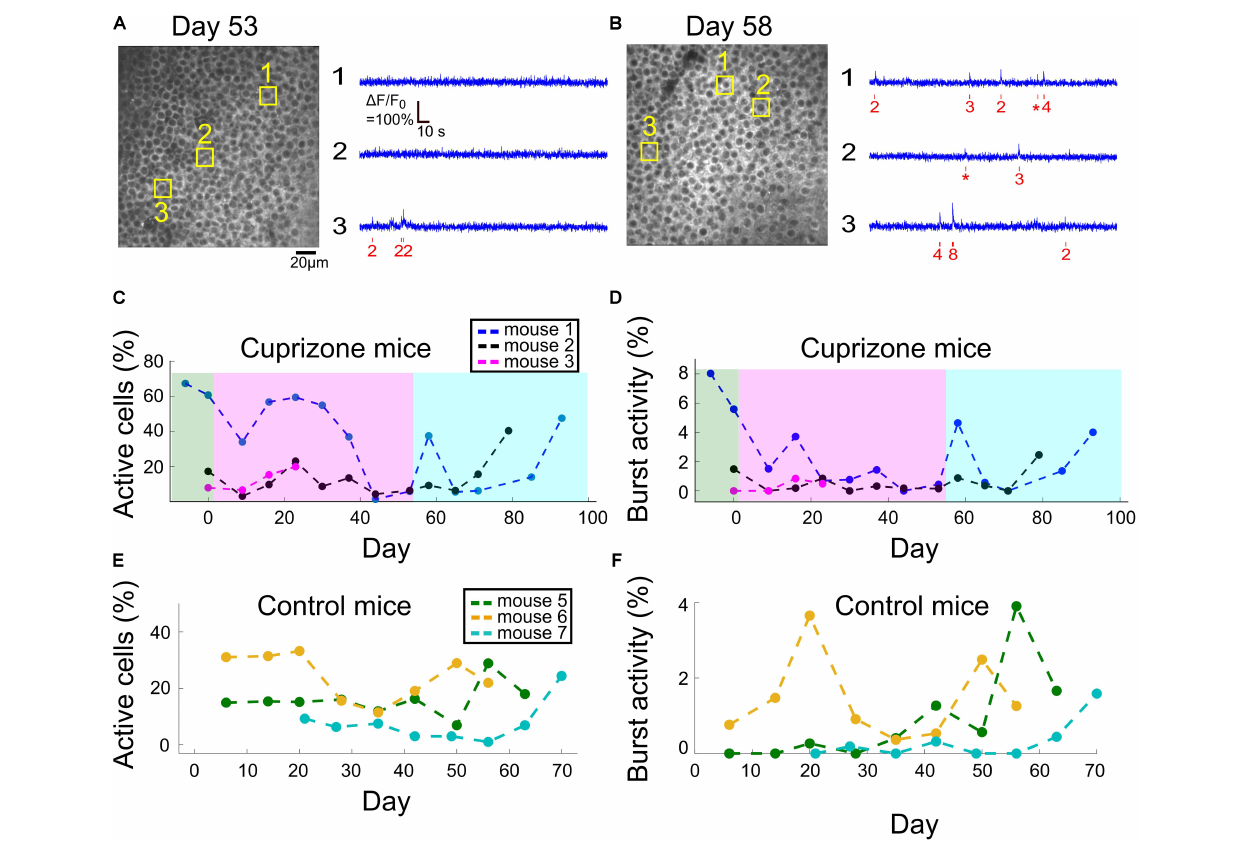
FIGURE 4 | Changes to DG activity patterns during demyelination and remyelination. (A) An example field of view of DG neurons from mouse 1, after 53 days of cuprizone diet, with activity traces of three example cells. The estimated timing and number of APs is shown (red) beneath each raw data trace (blue). (B) An example field of view of DG neurons from mouse 1, 5 days after the end of the cuprizone diet, with activity traces of three example cells. The estimated timing and number of APs is shown (red) beneath each raw data trace (blue). (C) Summary of the fraction of active DG cells from all recorded DG cells for all cuprizone-treated mice. The low-level recorded activity of DG cells is in line with previous findings (Pilz et al., 2016). However, the cuprizone diet reduced the activity even further, and the termination of cuprizone diet was followed by a noticeable recovery. DG cells of mouse 3 could be recorded only during the first four recording sessions. (D) Summary of the fraction of DG cells that fired bursts of APs from all recorded DG cells in cuprizone-treated mice shows a similar trend to the change in CA1 activity patterns. Colors are the same as in panel (C) . (E) Summary of the fraction of active DG cells from all recorded DG cells for all control mice. (F) Summary of the fraction of DG cells that fired bursts of APs from all recorded DG cells in control mice. Colors are the same as in panel (E)